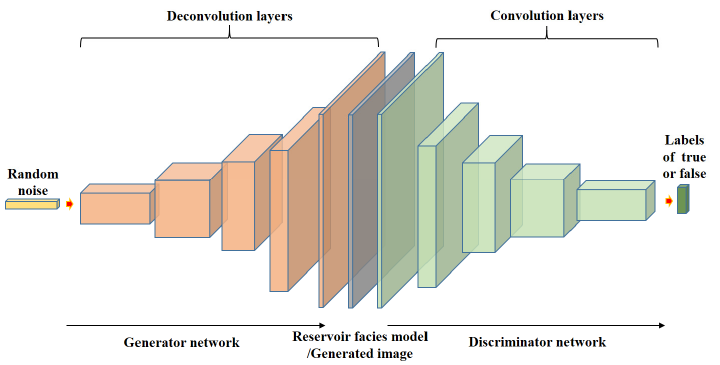
Figure 5. Schematic diagram of architecture of deep convolutional generative adversarial networks.